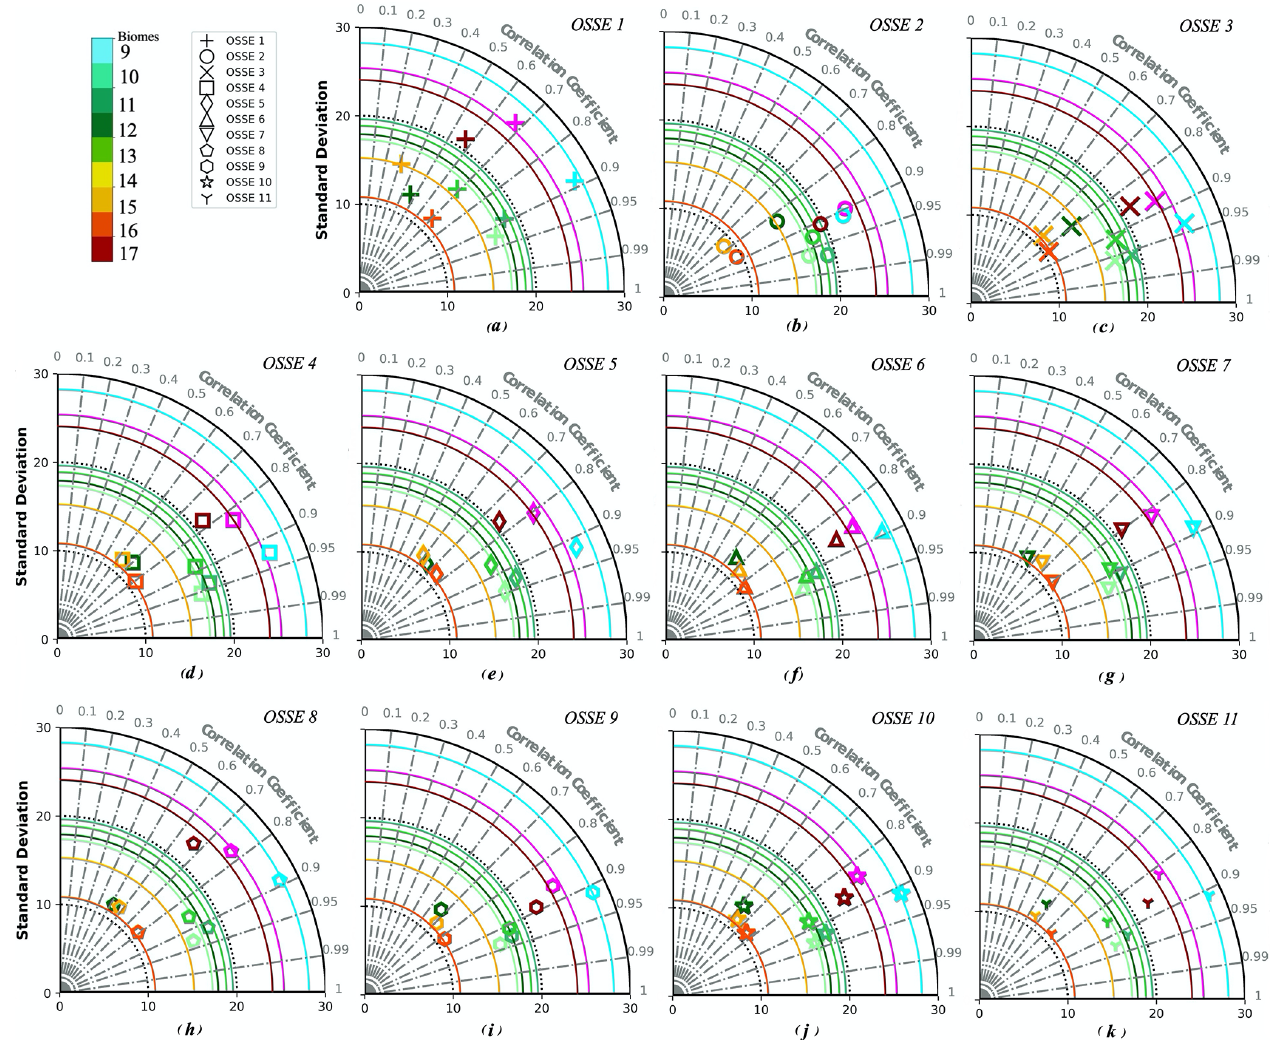
Figure 3. Taylor diagram of 11 OSSEs summarised in Table 2; the colour code corresponds to Fig. 2, and the purple colour represents all of the eight biomes combined: (a) OSSE 1, which uses SOCAT data only; (b) OSSE 2, which uses synthetic Argo data only; (c) OSSE 3, which uses SOCAT and synthetic Argo data; (d) OSSE 4, which uses SOCAT data and 25% of the original synthetic Argo data; (e) OSSE 5, which uses SOCAT data and 10% of the original synthetic Argo data; (f) OSSE 6, which uses SOCAT data and synthetic Argo data in the Southern Hemisphere; (g) OSSE 7, which uses SOCAT data and 25% of the original synthetic Argo data in the Southern Hemisphere; (h) OSSE 8, which uses SOCAT data and 10% of the original synthetic Argo data in the Southern Hemisphere; (i) OSSE 9, which uses SOCAT data, synthetic Argo data in the Southern Hemisphere, and data from mooring stations; (j) OSSE 10, which uses SOCAT data, 25% of the original synthetic Argo data in the Southern Hemisphere, and data from mooring stations; and (k) OSSE 11, which uses SOCAT data, 10% of the original synthetic Argo data in the Southern Hemisphere, and data from mooring